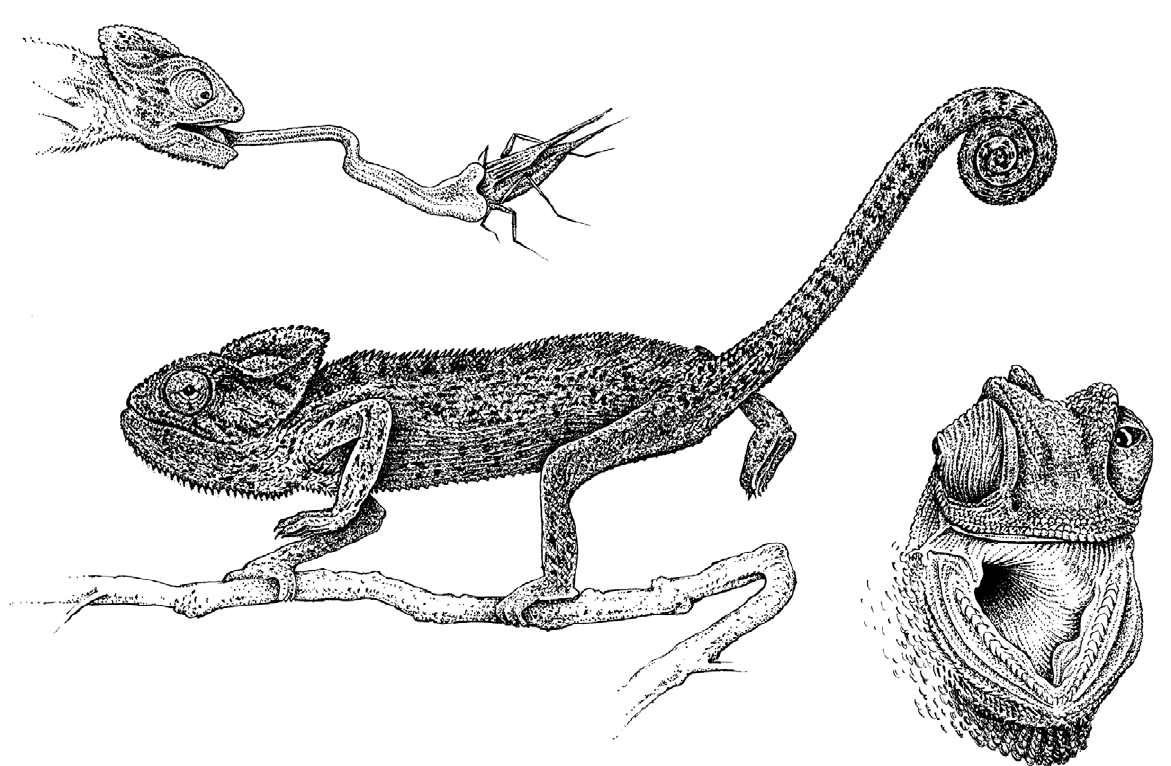
Image 6. Indian Chameleon Chamaeleon zeylanicus . Drawn using technical pen (Rotring